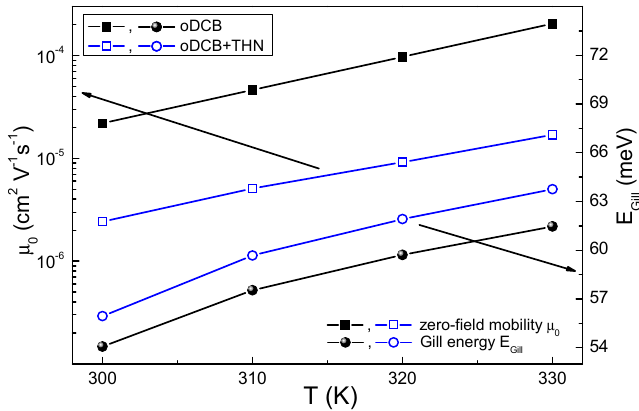
Figure 6. Temperature dependence of the zero-field mobility (left y -axis) and of the Gill energy (right y -axis). Full and open symbols correspond to oDCB and oDCB+THN solvent, respectively.